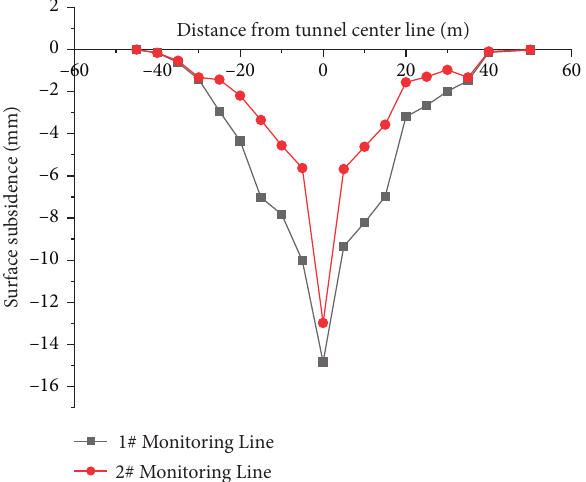
Figure 11: Measured surface settlement